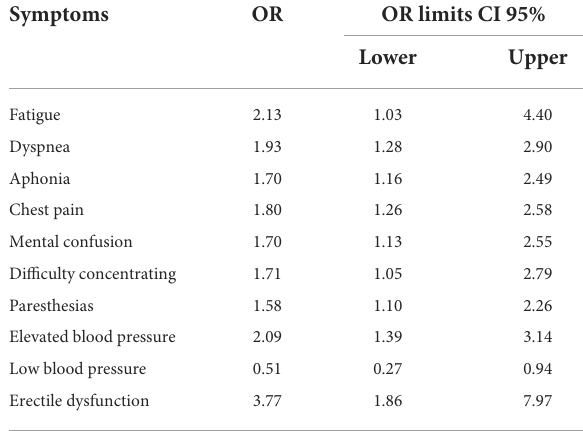
TABLE 2 Relationship between long COVID symptoms and vaccination.